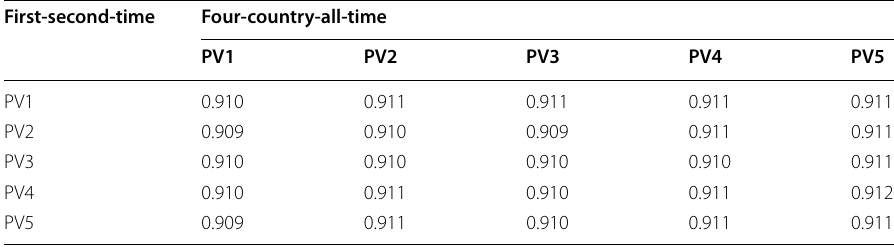
All correlations are significant, df